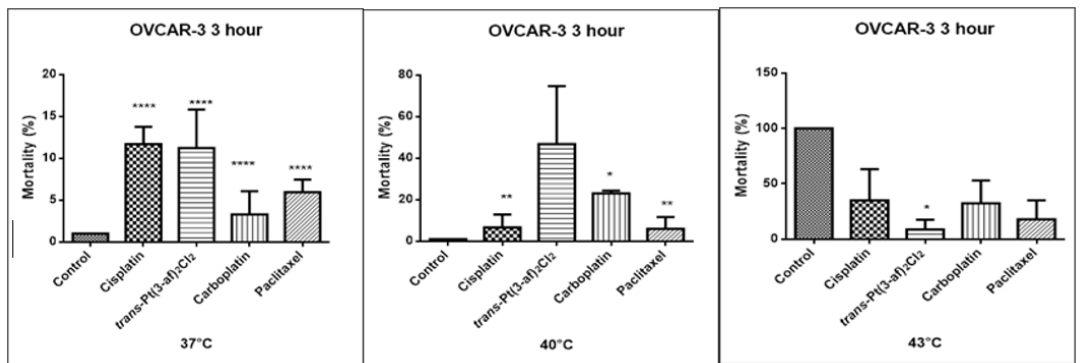
Figure 7 . The effect of the elevated temperature of the tested preparations (43 °C) on the cells of the Caov-3 ovarian cancer line was determined by the LDH test. Data on the figures are presented as mean values obtained from three independent experiments * ( p < 0.05), ** ( p < 0.01), *** ( p < 0.001), **** ( p < 0.0001).